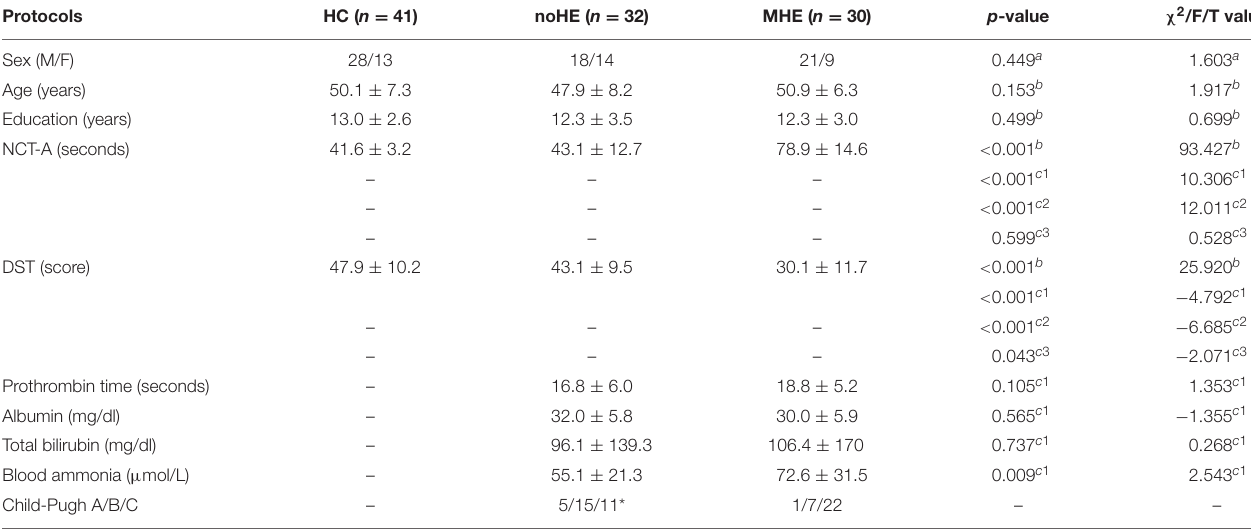
TABLE 1 | Demographic, neuropsychological and clinical